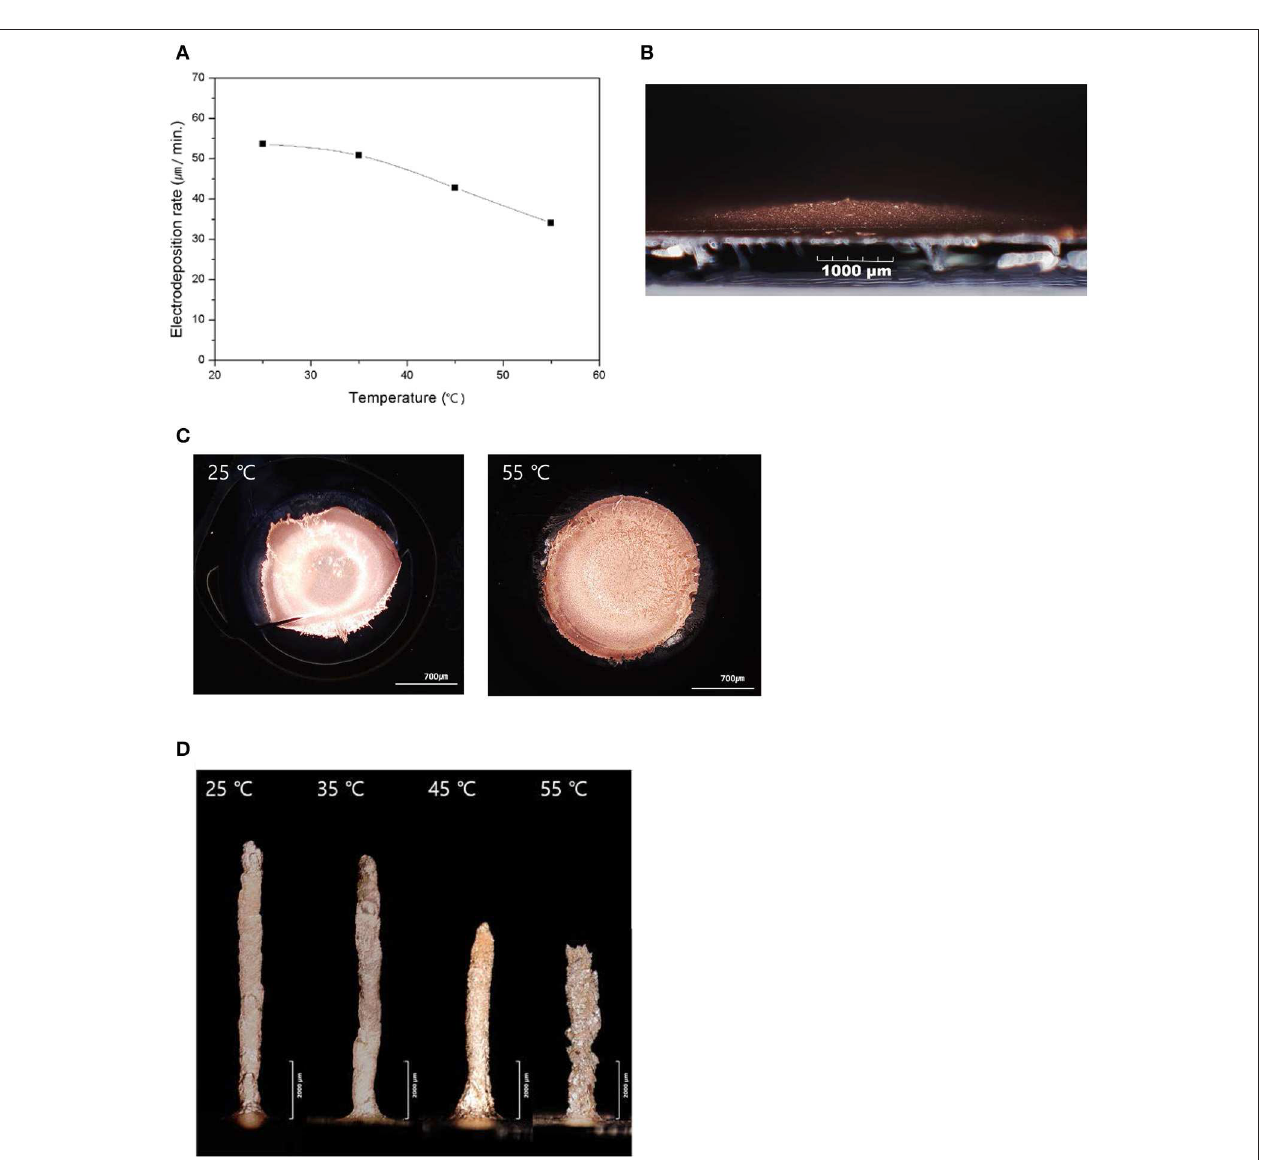
FIGURE 2 | Electroplating characteristics according to the electrolyte temperature, in which the small letters denote the following: (A) electrodeposition rate depending on the electrolyte temperature; (B) initial convex shape of deposition of Cu; (C) shape of the initial Cu deposit structures obtained at different temperatures; (D) directional growth of the pillars depending on the electrolyte